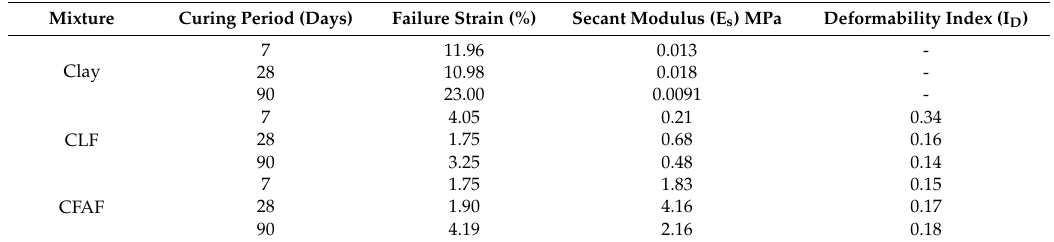
Table 6. Result of failure strain, secant modulus and deformability index for untreated and treated